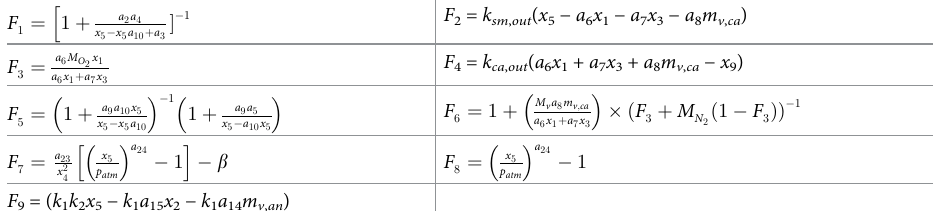
Table 2. Functions F 1 — F 9 used in state space